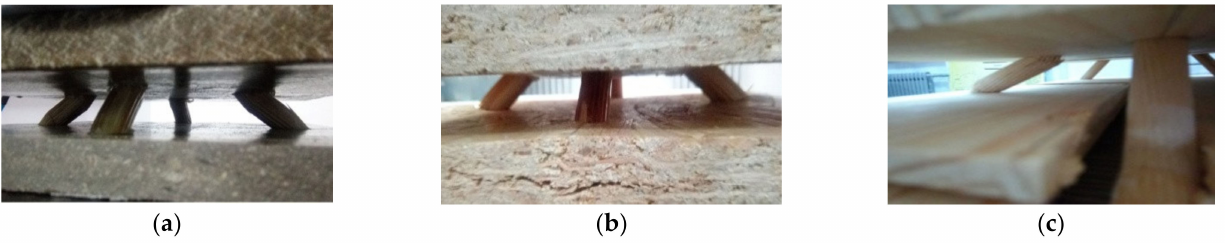
Figure 4. Failure modes of wood-based pyramid structure specimens. ( a ) WPC + Birch; ( b ) OSB + Birch; ( c ) Larch +